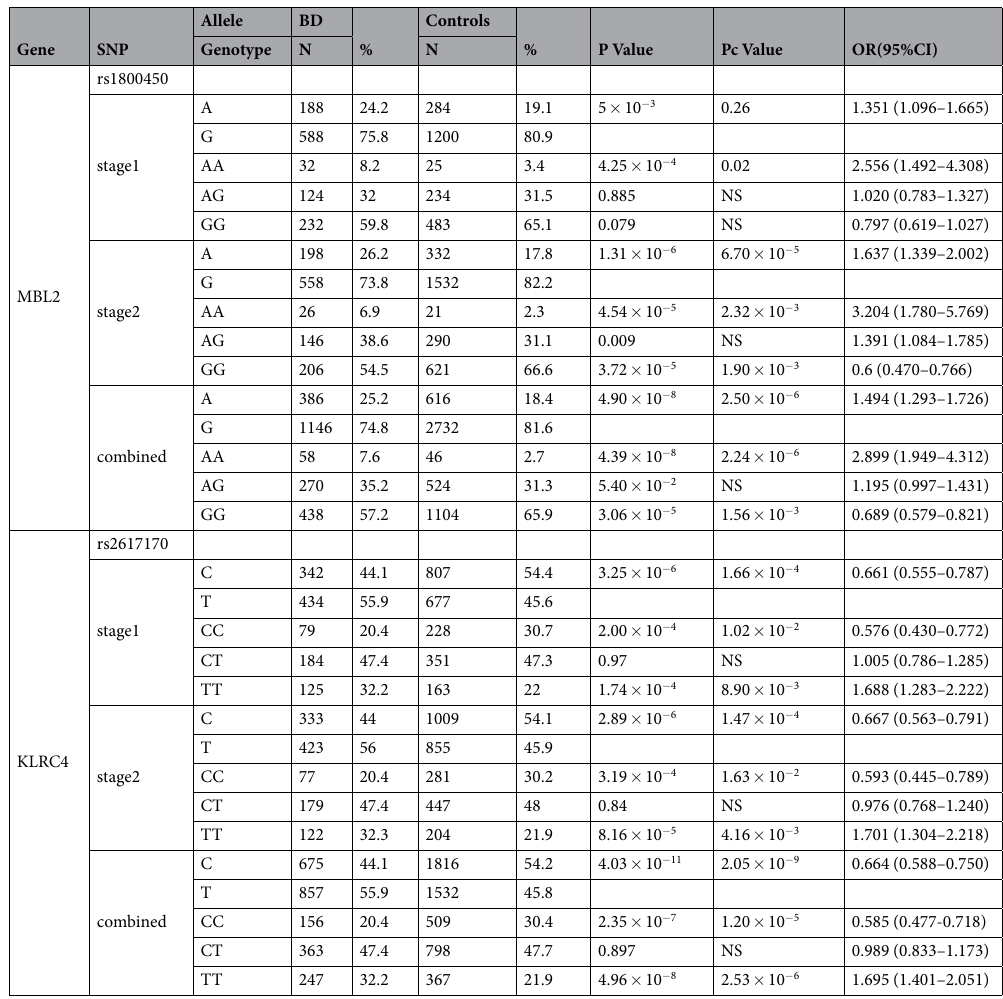
Table 2. Genotype and allele frequencies of MBL2 and KLRC4 polymorphisms in BD and healthy controls. SNP, single-nucleotide polymorphism; BD, Behcet’s disease; OR, odds ratio; NS, not significant; 95% CI, 95% confidence interval; Pc, Bonferroni corrected p